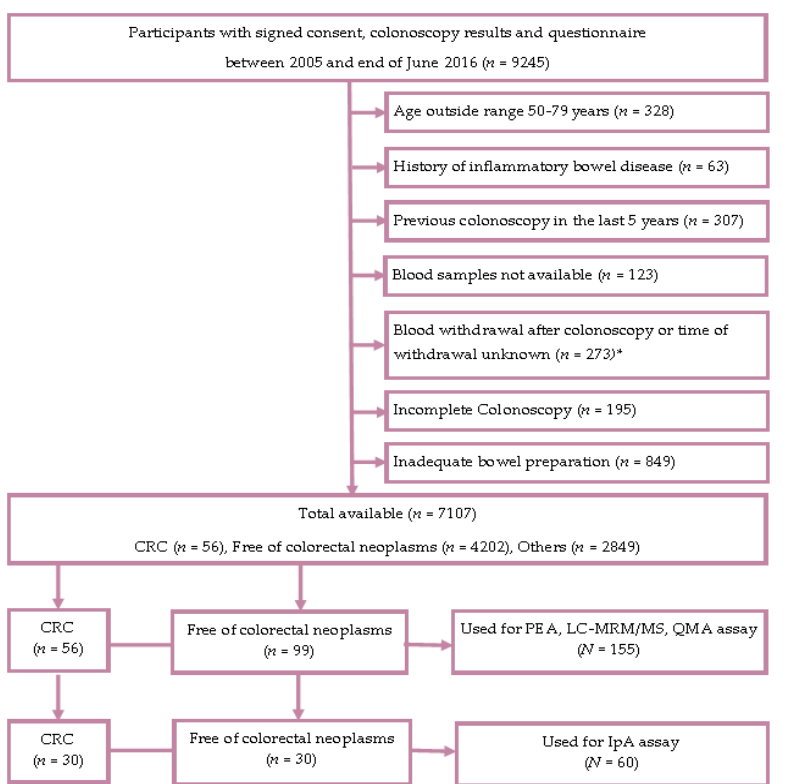
Figure 1. STARD (Standards for the Reporting of Diagnostic Accuracy) flow diagram (BLITZ study). Abbreviations: CRC, colorectal cancer; IpA, immunome protein array; LC/MRM-MS, liquid chromatography/multiple reaction monitoring– mass spectrometry; n / N , number; SD, standard deviation; PEA, proximity extension assay; QMA, quantibody microarray. * The exclusion criteria for the selection of CRC cases were not applicable after this point.